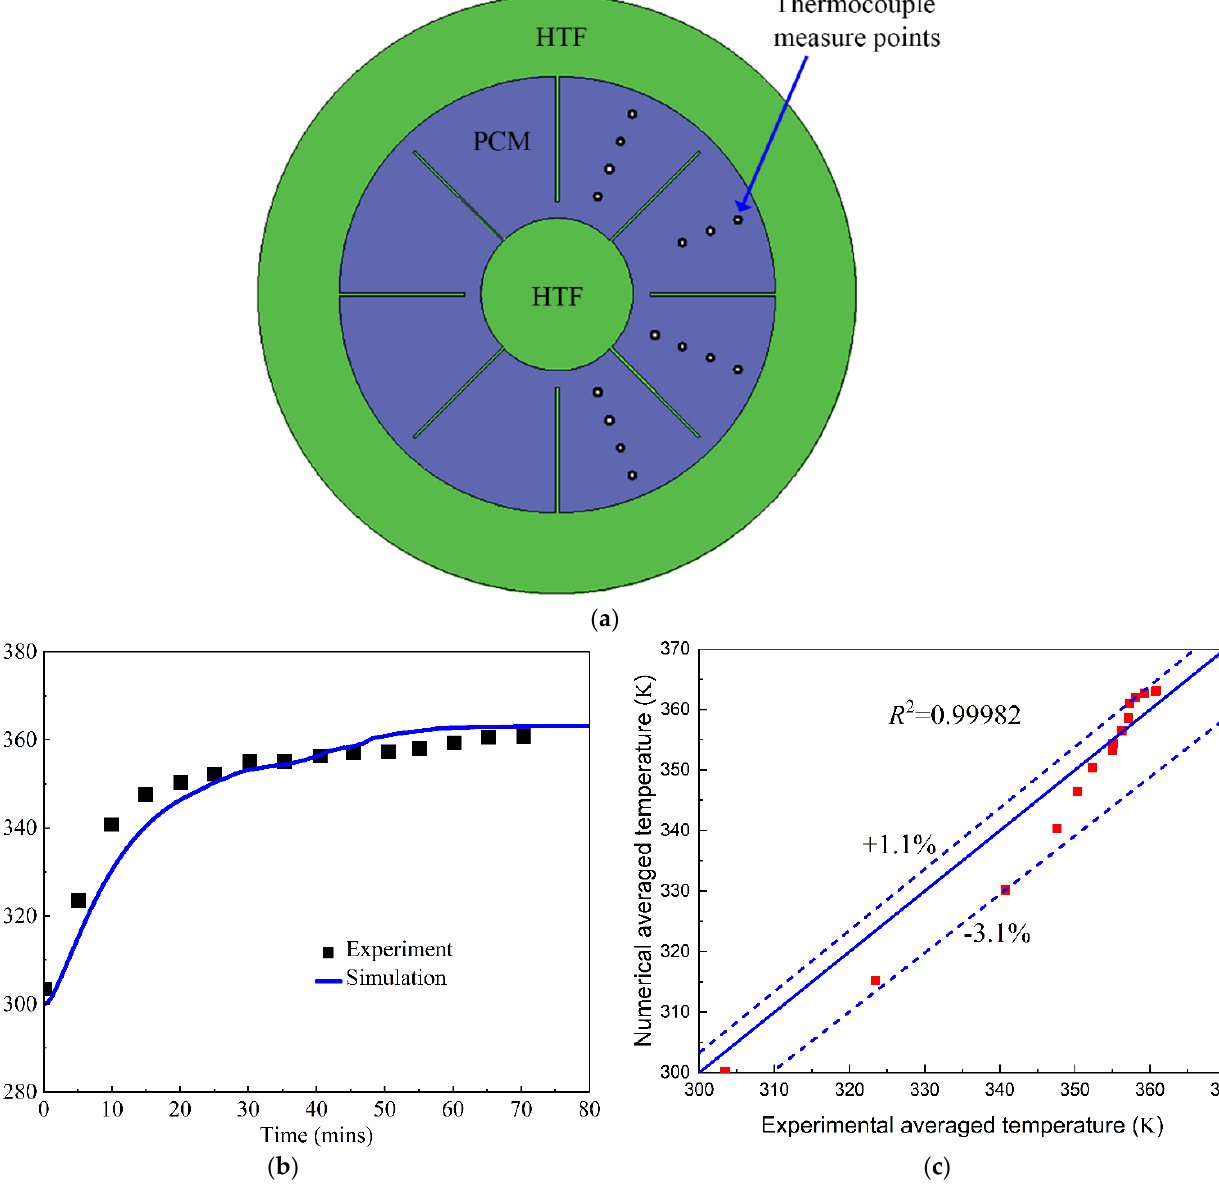
Figure 5. Model validation of the melting process of phase change materials. ( a ) Thermocouple measure points in the experiments [32]; ( b ) Average temperature; ( c ) Error analysis.